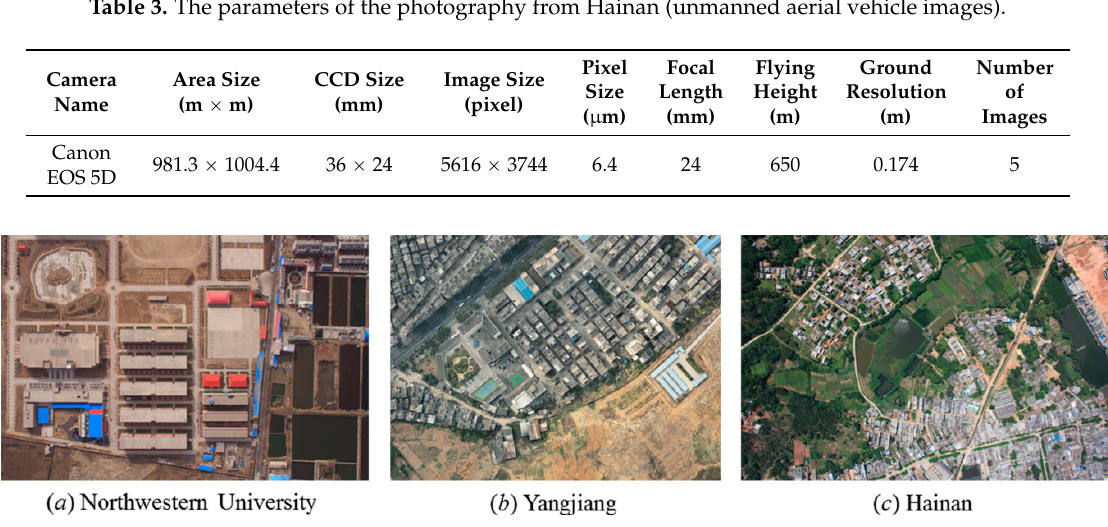
Figure 4. Sample input images of all the data sets used in the experiments. ( a ) Northwestern University; ( b ) Yangjiang; ( c ) Hainan.